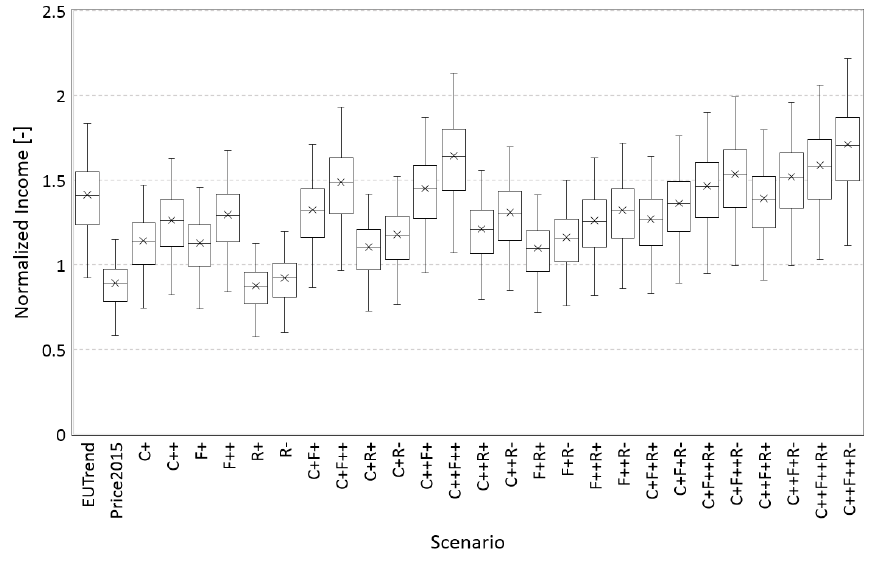
Figure 6. Boxplots of normalized incomes (according to 2015) for all price scenarios in 2030.